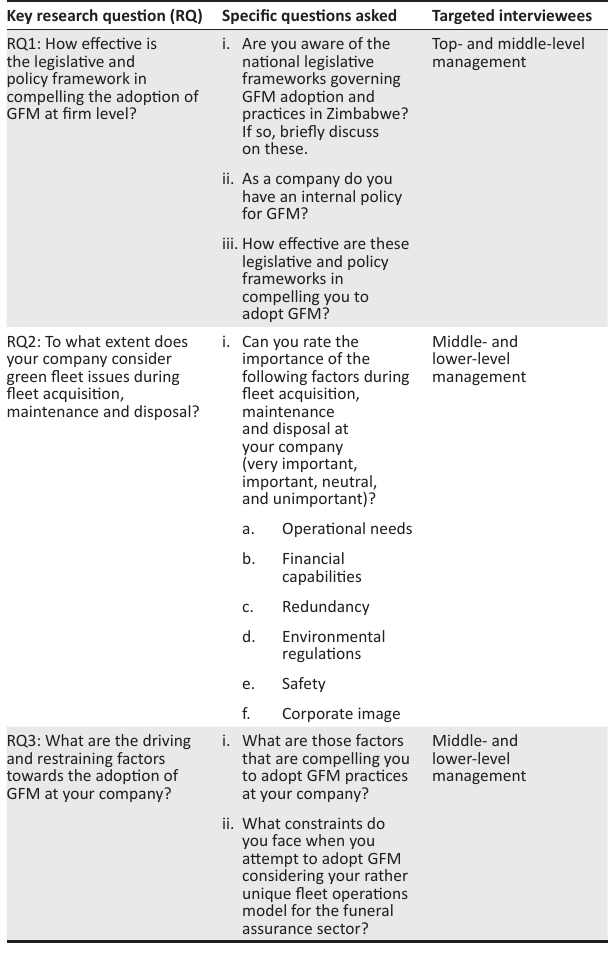
TABLE 4: Key research questions asked during the key informant